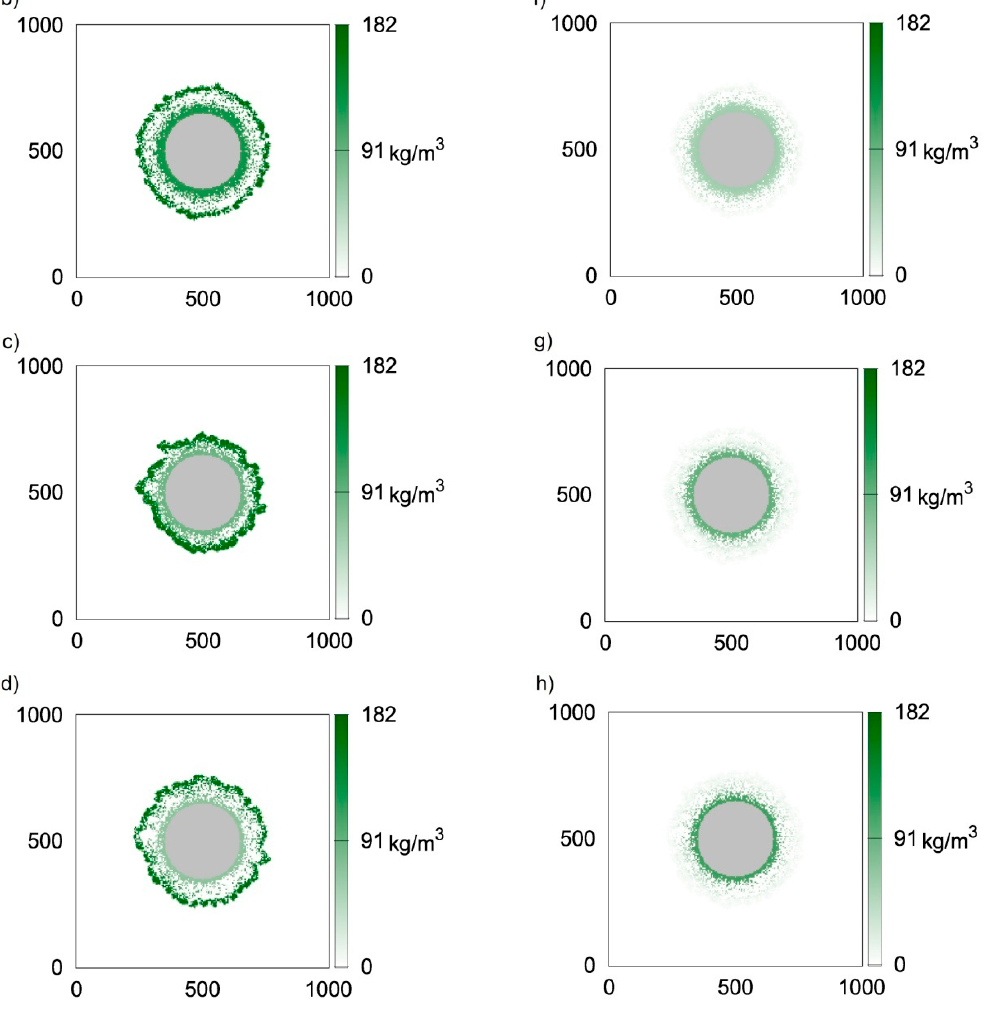
Figure 3. Two-dimensional distributions of active (left) and inert (right) biomass density in spherical biofilm obtained with the use of CA-2; values on vertical and horizontal axes are expressed in µ m; successive rows represent time moments: ( a ), ( e ) t = 50 h; ( b ), ( f ) t = 100 h; ( c ), ( g ) t = 150 h; ( d ), ( h ) t = 200 h.